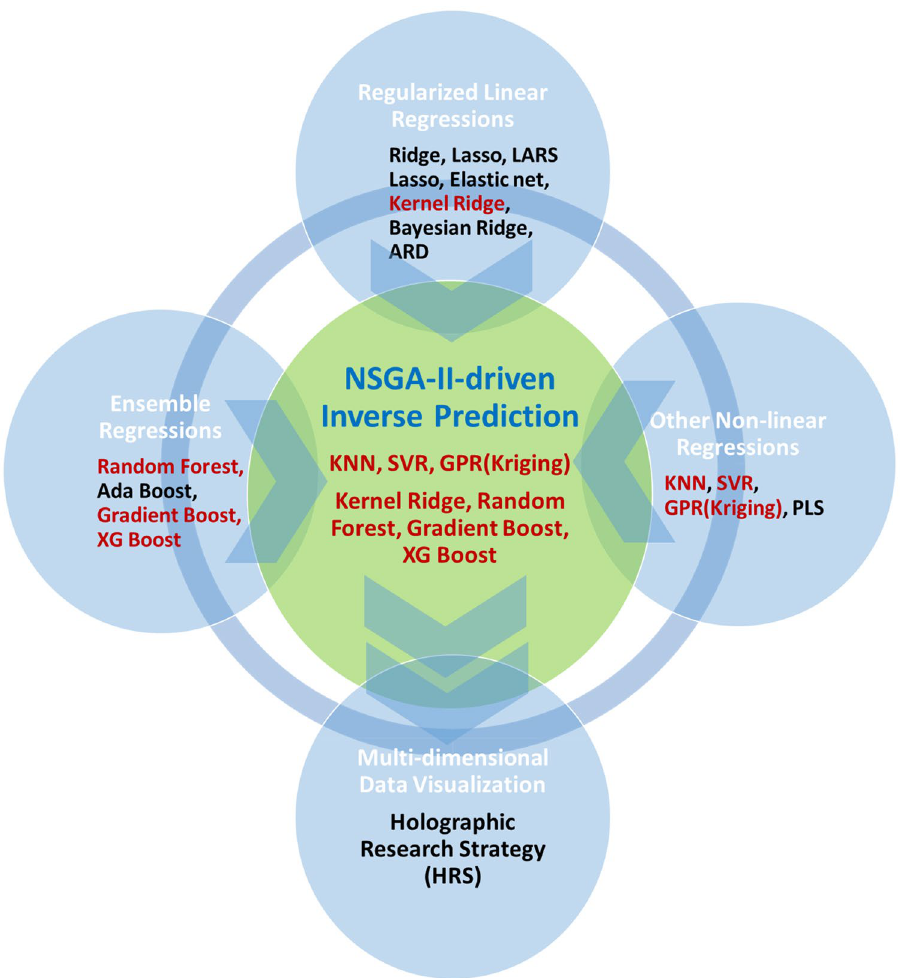
Figure 7. The overall graphical description for the integrated ML platform. Three groups of ML algorithms, the NSGA-II-driven inverse prediction, and the high-dimensional data visualization method are